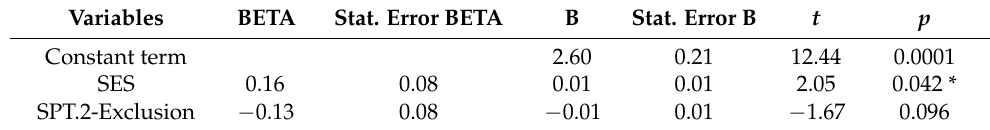
Table 8. Determinants of the ‘emotional support’ variable (ES).